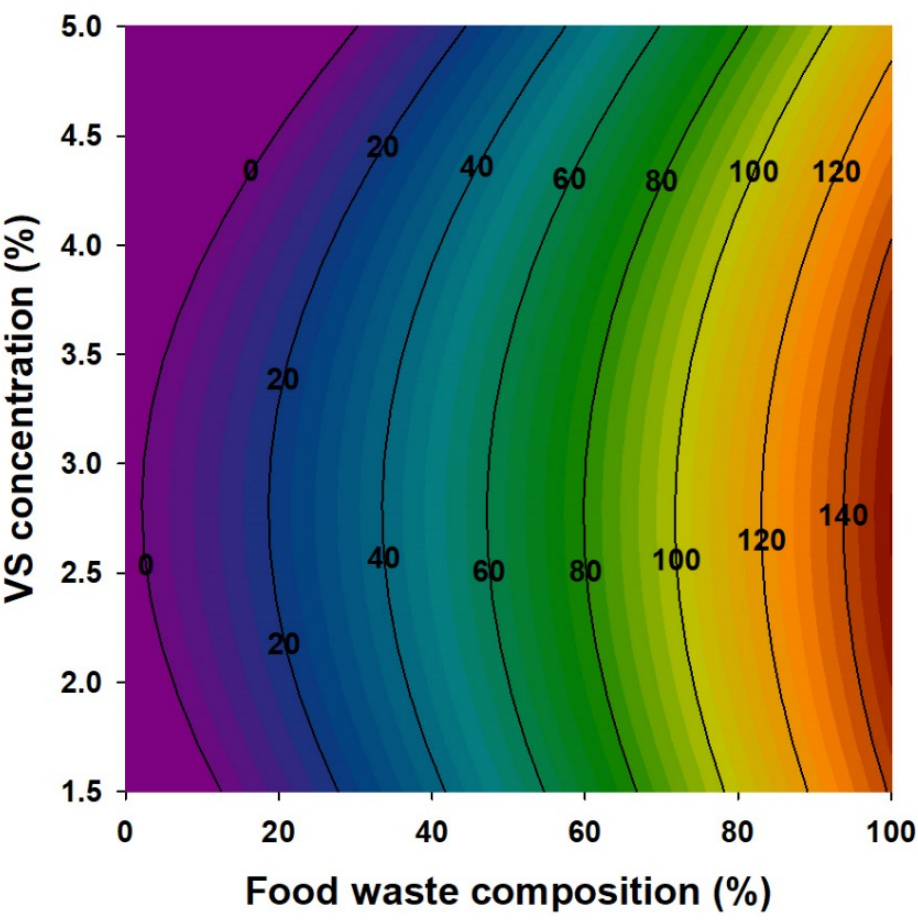
Table 4. Analysis of variance for hydrogen production potential.